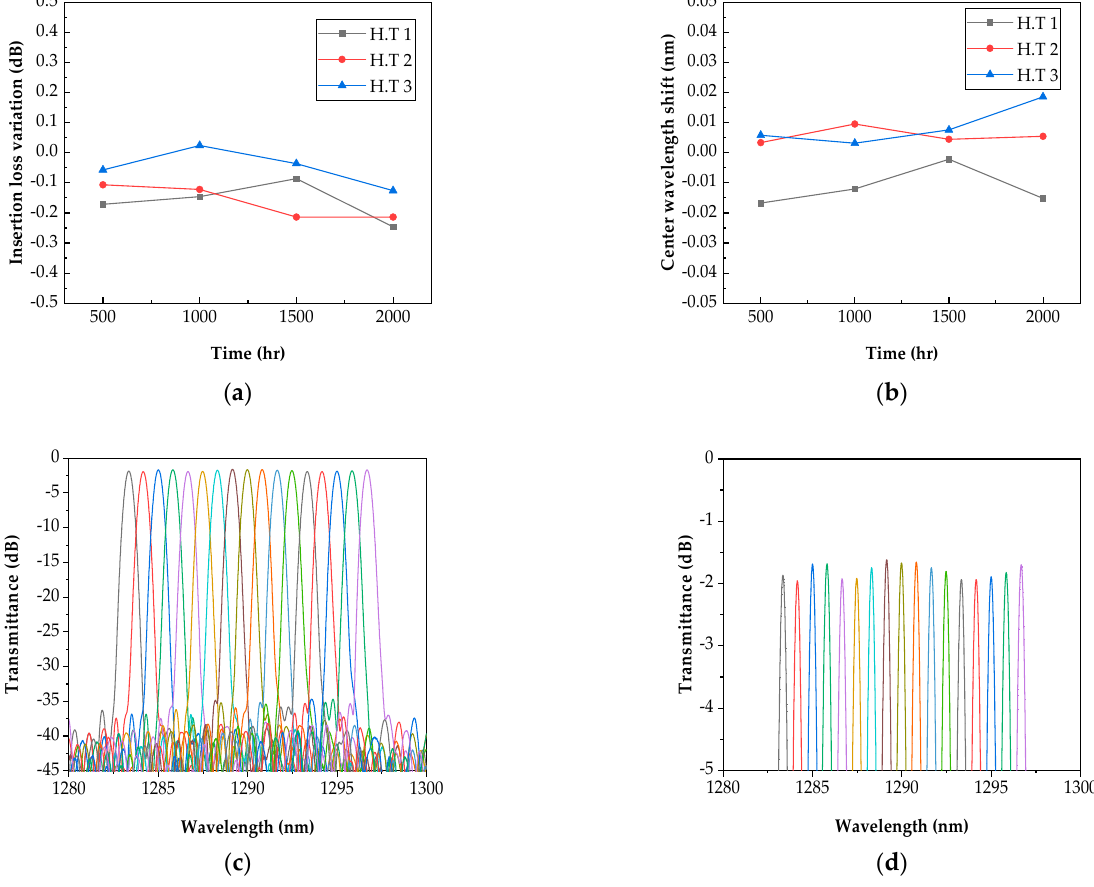
Figure 7. Average results of 17 channels in three AAWG modules after high storage temperature